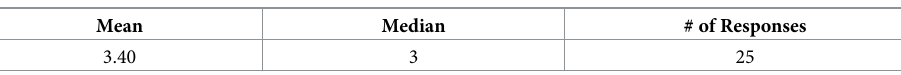
Table 2. Alumni preparedness.